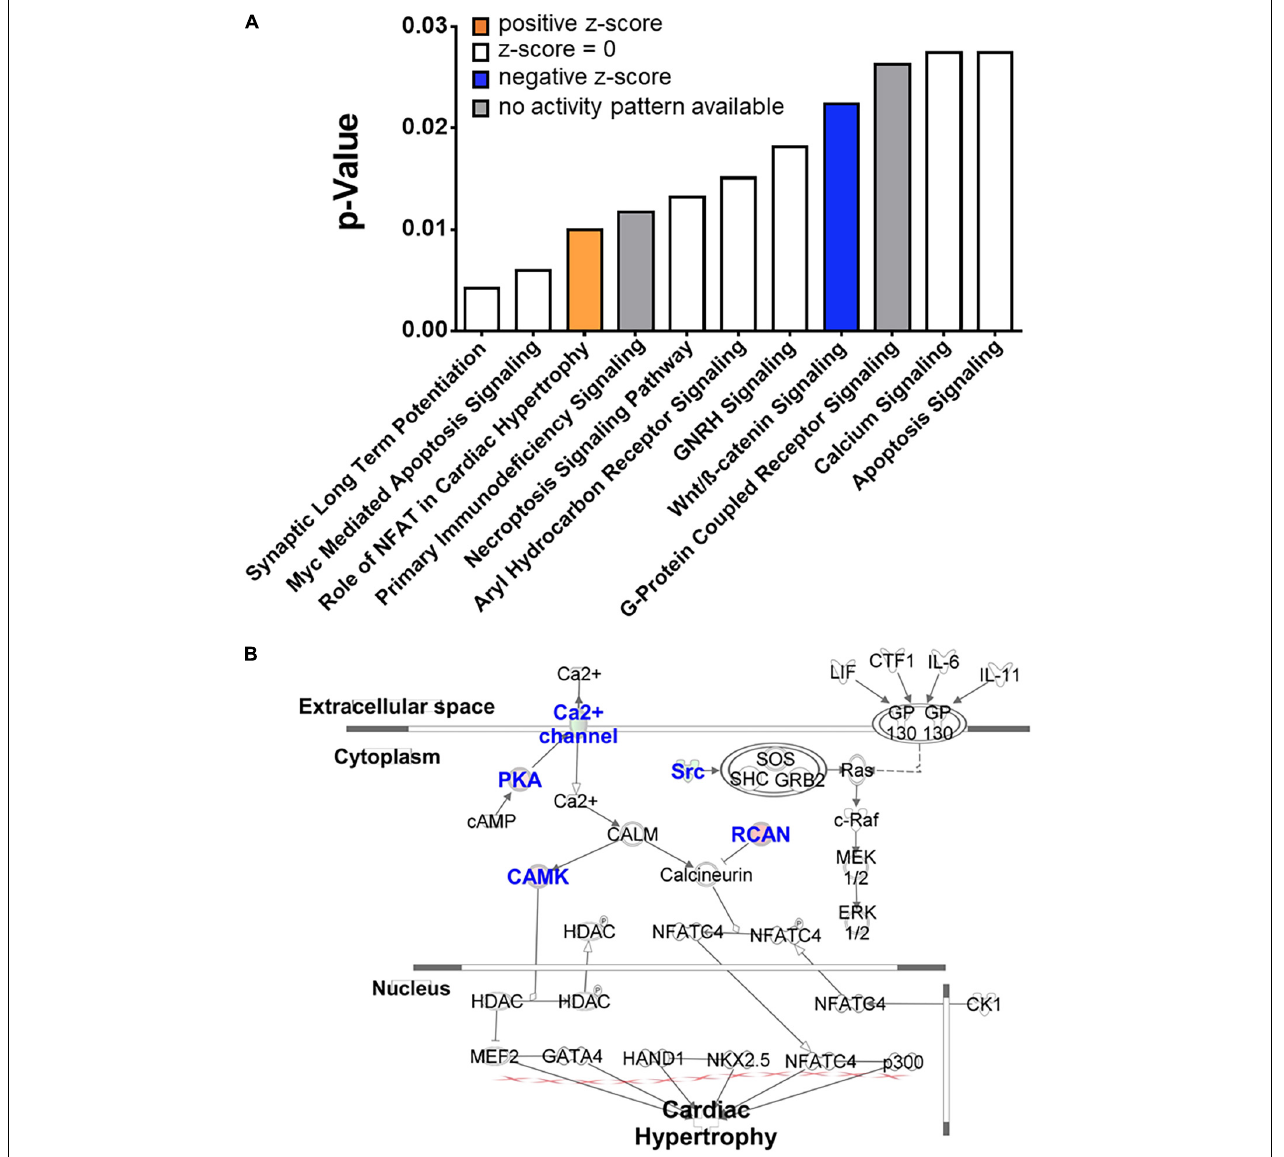
FIGURE 3 | Top significantly altered cellular signaling pathways in the heart of GF mice in normoxia. (A) Transcriptome profiling suggested significant alterations of multiple cellular signaling pathways in the heart of GF mice (right-tailed Fisher’s exact test, p < 0.05, Supplementary Table 3 ), including (B) activation of the pathway regulating the “role of NFAT in cardiac hypertrophy.” Blue fonts: significantly altered components of the pathway.